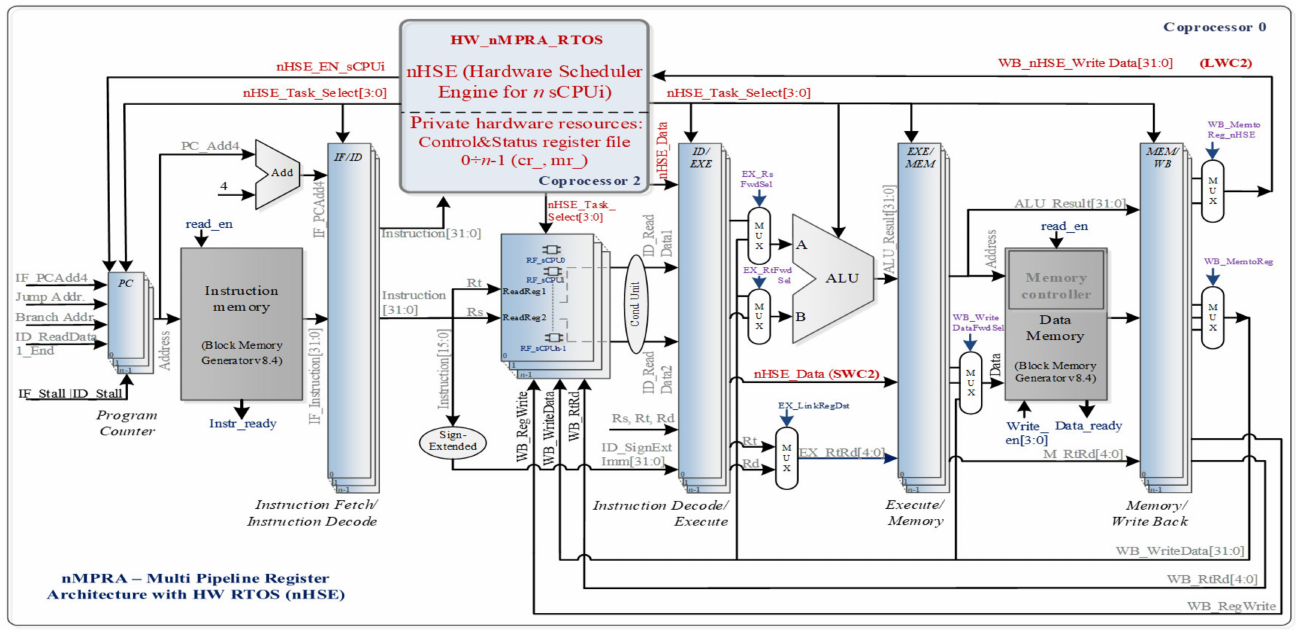
Figure 2. HW_nMPRA_RTOS microarchitecture with nHSE representing an RTOS implemented in hardware based on LWC2- and SWC2-type